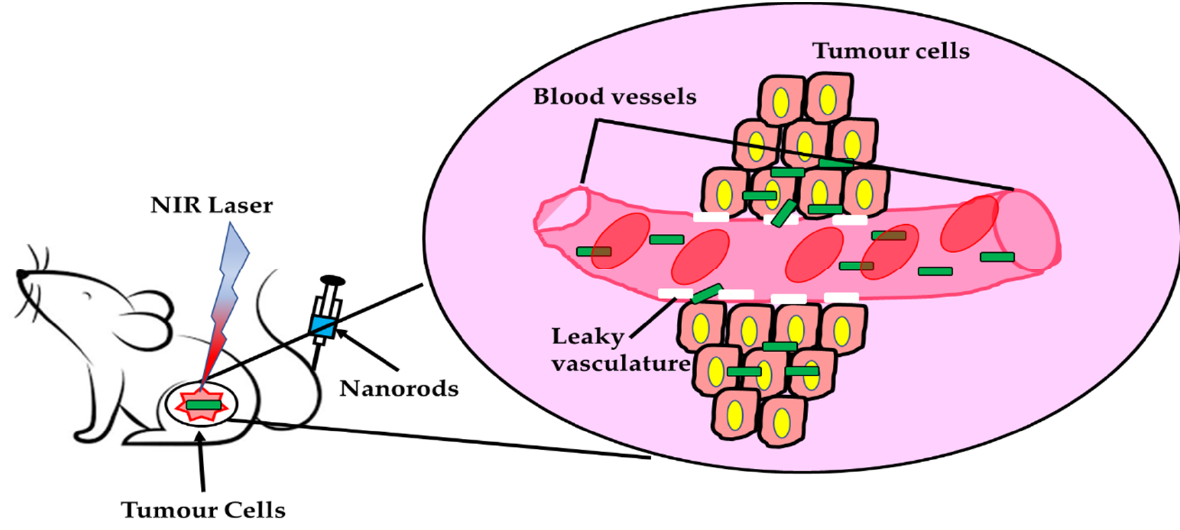
Figure 3. Represents the targeting of nanorods for theranostics.